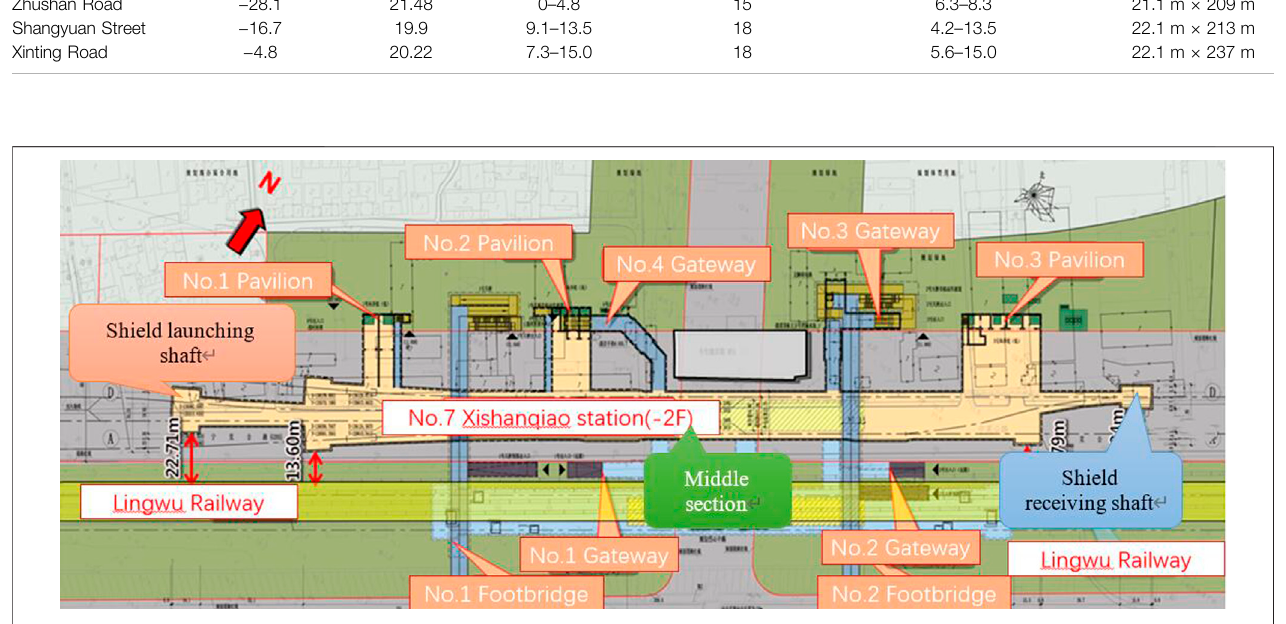
FIGURE 1 | Layout of Xishanqiao station.